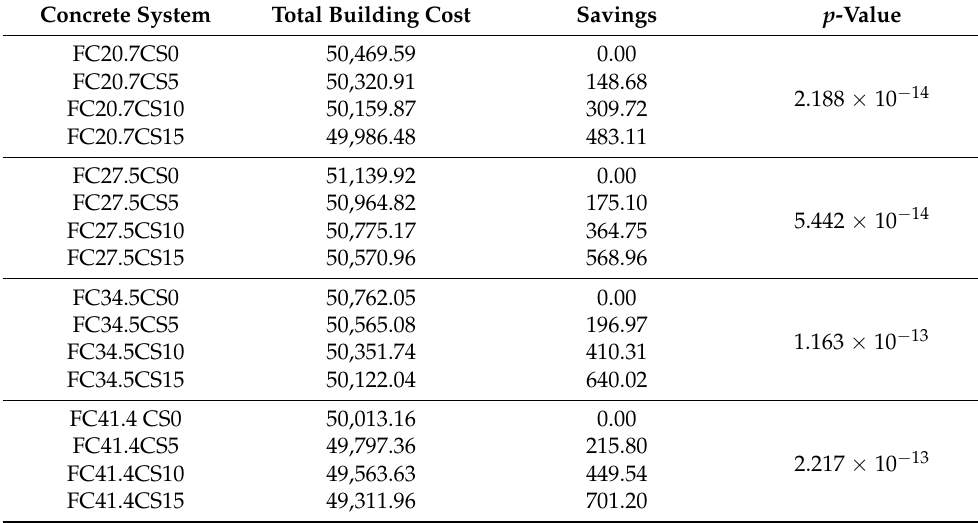
Table 12. Three-story building cost and cost savings, along with corresponding p- value.